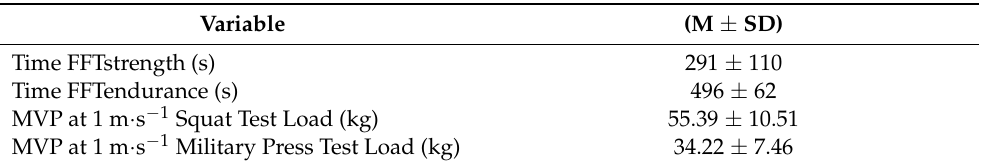
Table 1. Descriptive analysis of FFT times and MVP at 1 m·s −1 Squat and Military Press Test of the 18 study participants.